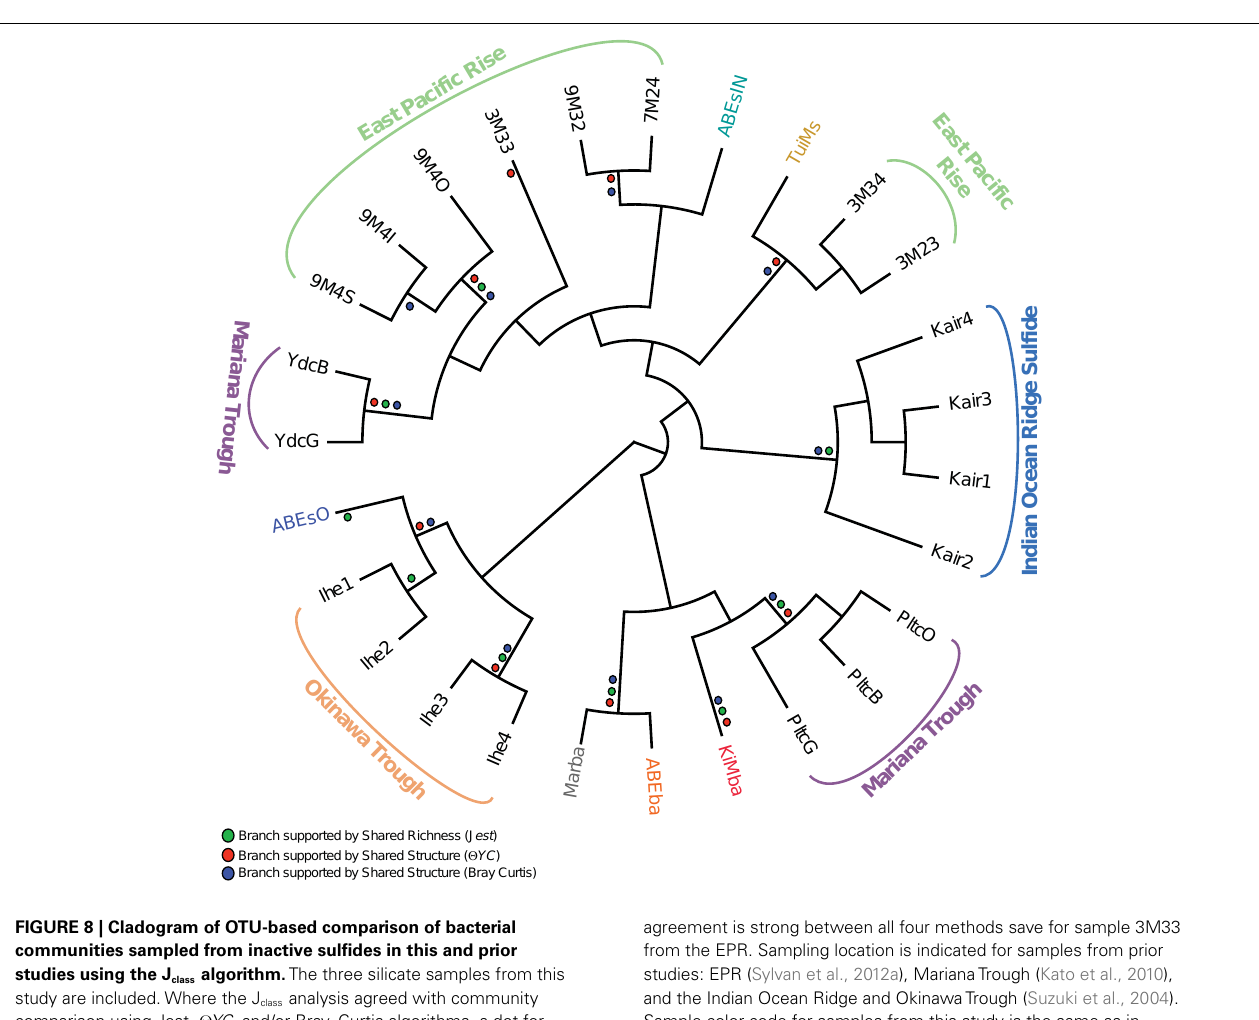
FIGURE 8 | Cladogram of OTU-based comparison of bacterial communities sampled from inactive sulfides in this and prior studies using the J class algorithm. The three silicate samples from this study are included.Where the J class analysis agreed with community comparison using Jest, Θ YC , and/or Bray–Curtis algorithms, a dot for the agreeing methods is placed at the node in the cladogram. Overall